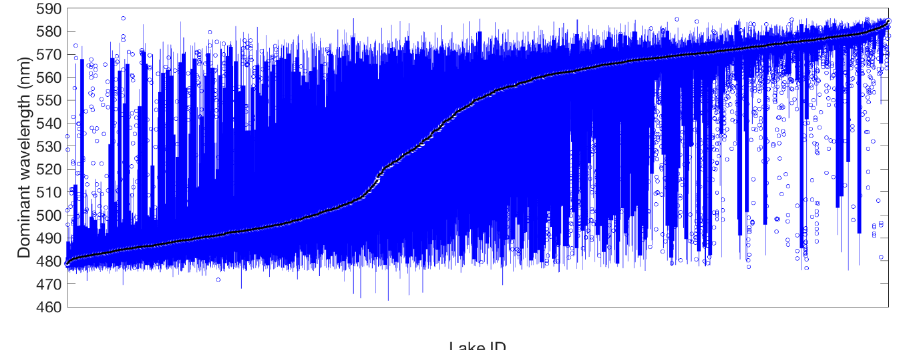
Figure 10. Box plot of the distribution of dominant wavelength in 1486 lakes ordered by median dominant wavelength (black line). The bottom and top edges of each box indicate the 25th and 75th percentiles, respectively; blue lines extend to the most extreme data points not considered outliers, and outliers are shown as circles.